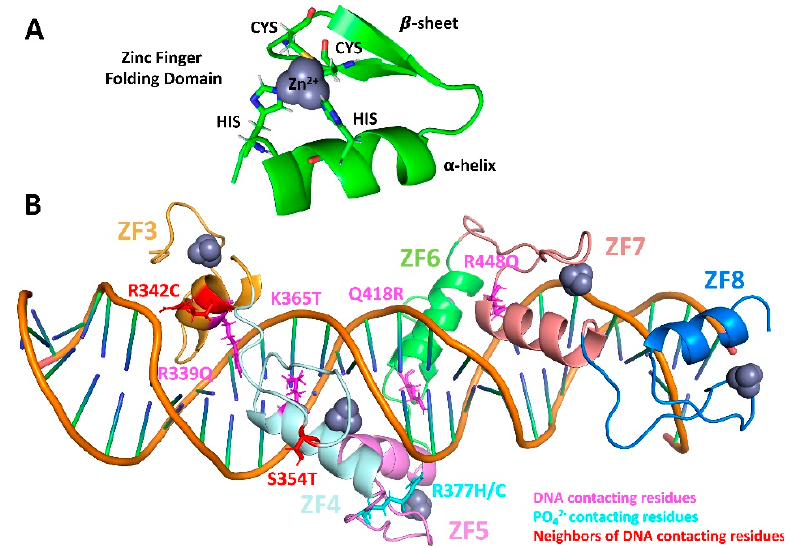
Figure 1. Zinc fingers stabilize the CTCF–DNA structure through protein/DNA contacts. ( A ) Zinc finger folding motif, with the coordination ring and the ββα domain. ( B ) 3D structure of the CTCF– DNA complex showing CTCF’s ZFs 3 to 8 color-coded, the Zn 2+ ions in violet, the residues that are mutated colored based on their interaction with DNA (pink), DNA PO 42 − groups (cyan), or with other residues that directly contact the DNA (red). Protein crystal structure obtained from [14].